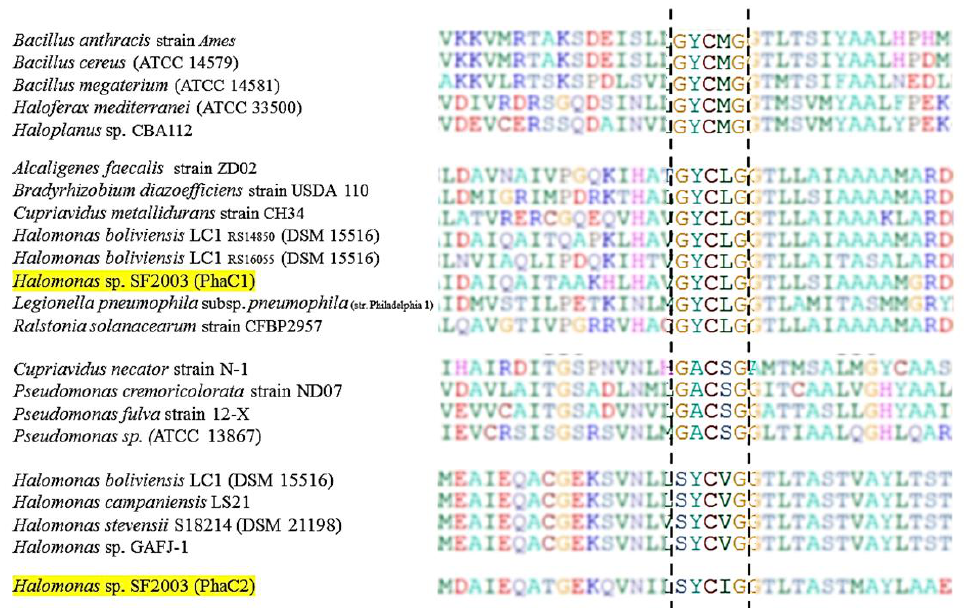
Figure 3. Multiple alignments of partial amino acid sequences of PHA synthase exposing lipase box-like patterns from different bacterial species. All the sequences are available on the National Center for Biotechnology Information (NCBI) database. Highlighted sequences correspond to PHA synthases PhaC1 and PhaC2 of Halomonas sp. SF2003.